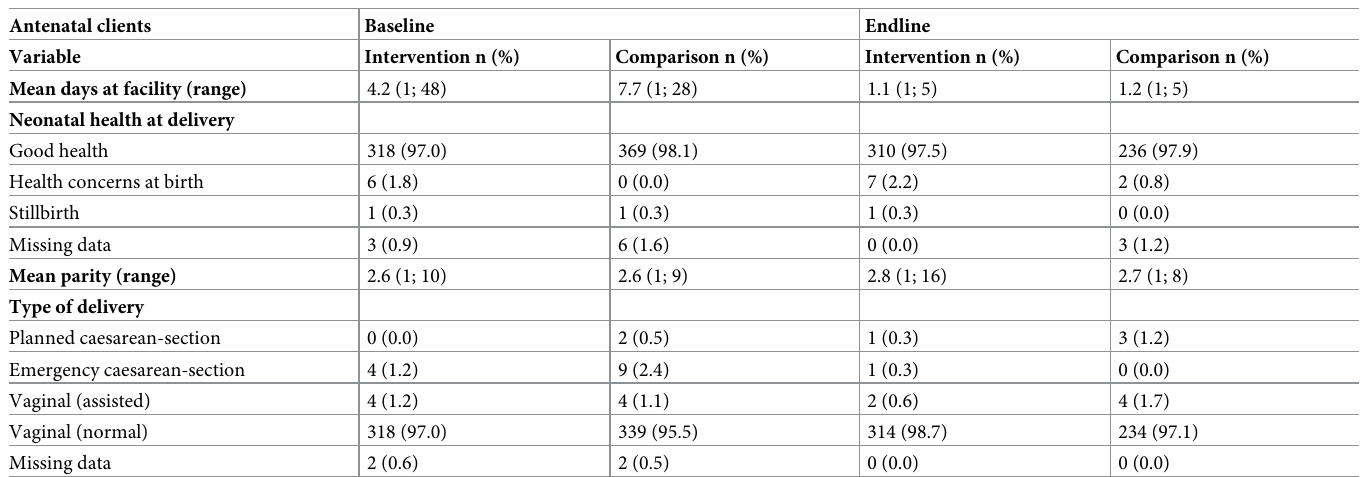
respectively at endline. At baseline, 44% and 49% of intervention and comparison clients respectively never attended school, compared to 38% and 54% respectively at endline. At base- line, mean gestational weeks were similar at 25.4 for intervention and 25.3 for comparison, shifting to 25.7 and 23.4 respectively at endline. At baseline, 33% and 23% of intervention and comparison clients respectively were primigravida, while 27% and 22% were on their second pregnancy at